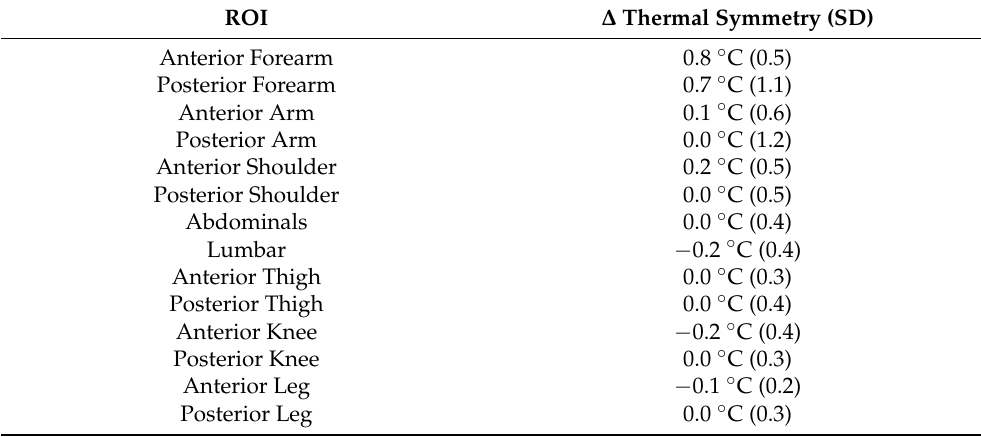
Table 3. Mean variation ( ∆ ) of thermal symmetry and standard deviation (SD) for each region